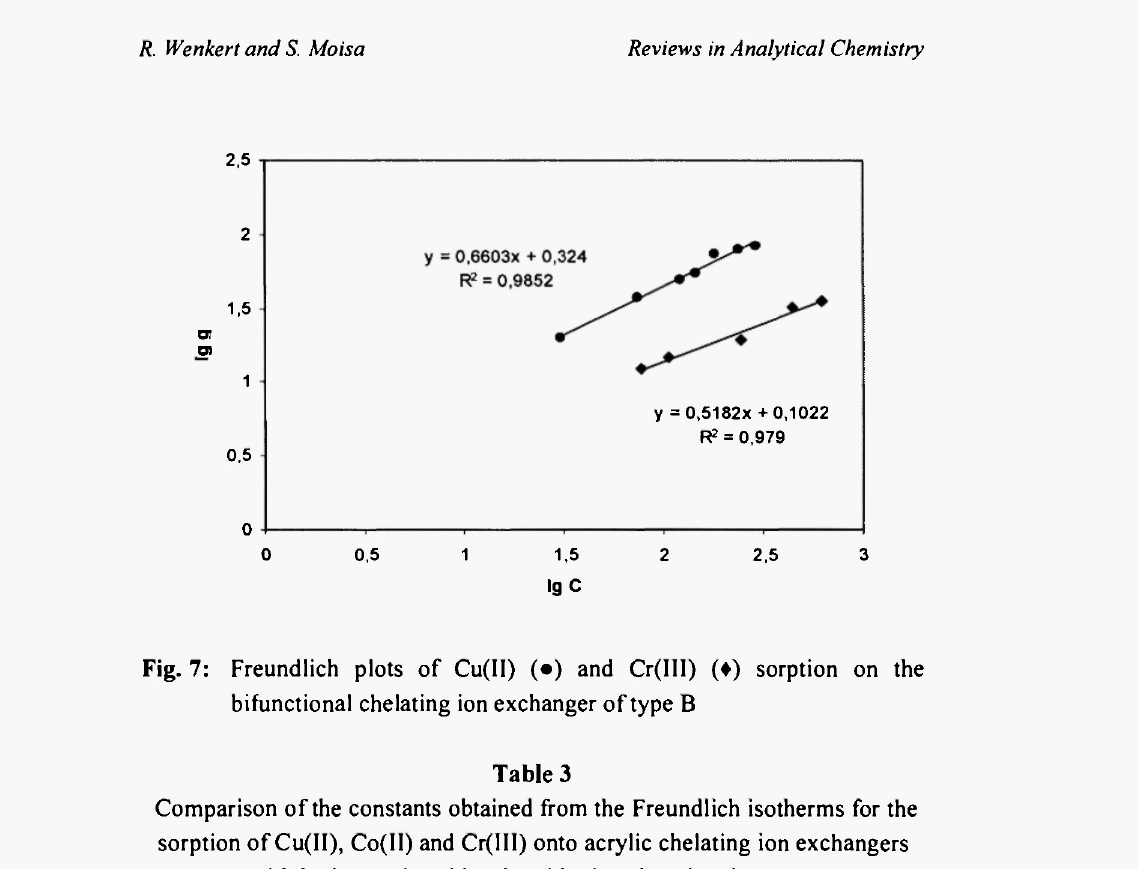
Freundlich plots of Cu(II) ( ·) and Cr(III) (•) sorption on the Afunctional chelating ion exchanger of type